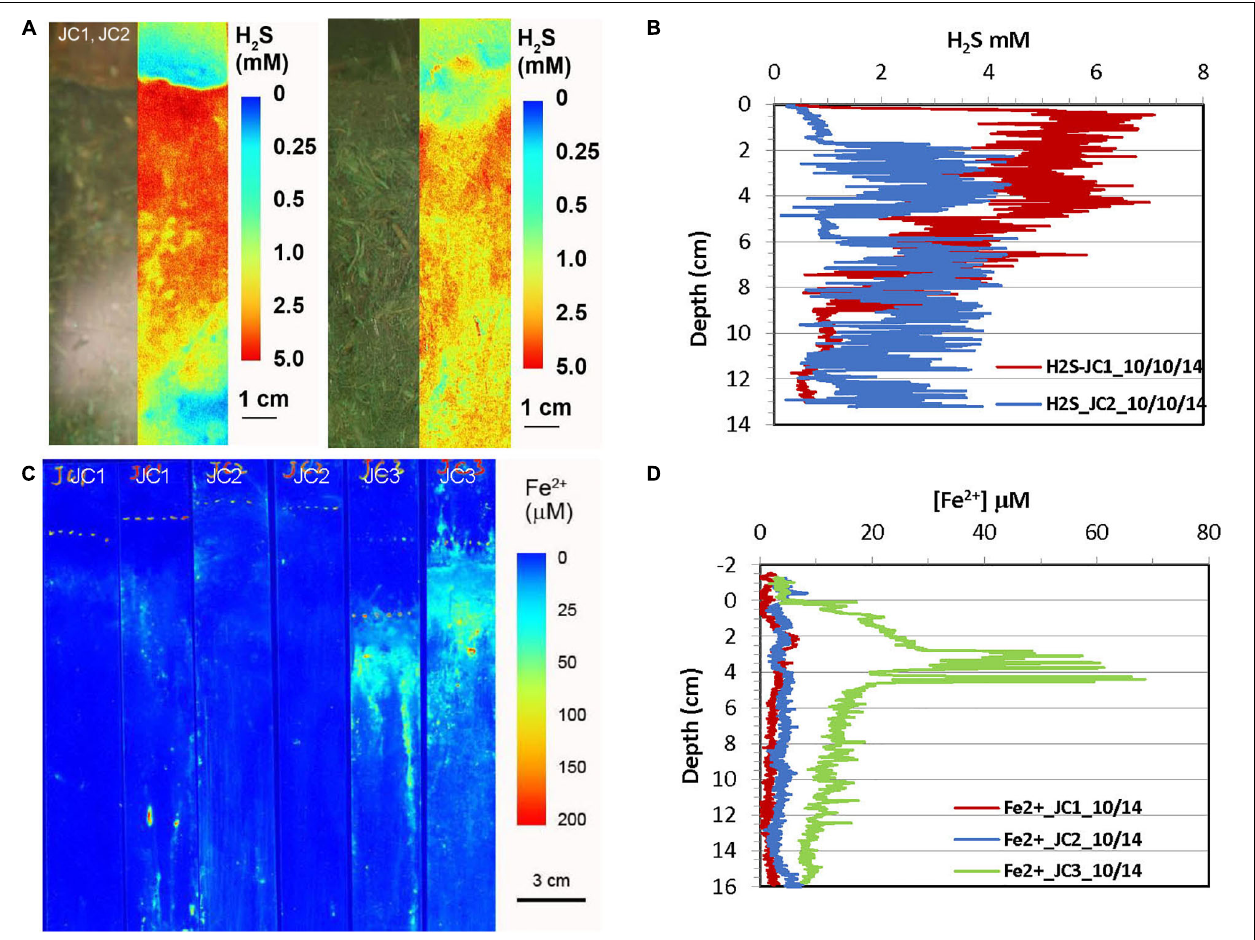
FIGURE 4 | H 2 S and dissolved Fe 2 + distribution patterns in the pore water of JoCo (JC) marsh peats in fall 2014. (A) 2-D H 2 S distribution patterns in the sediments which were incubated for 24 h in lab before H 2 S imaging. The green panels are physical image of sediments and the color panels (pseudo color) are corresponding 2-D H 2 S distributions. (B) Vertical H 2 S profiles averaged from each 2-D H 2 S distribution in panel (A) . (C) In situ 2-D Fe 2 + distribution patterns which were obtained by in situ deployments; white line marks the peat surface. (D) Vertical Fe 2 + profiles averaged from each 2-D Fe 2 + distributions in panel (C)